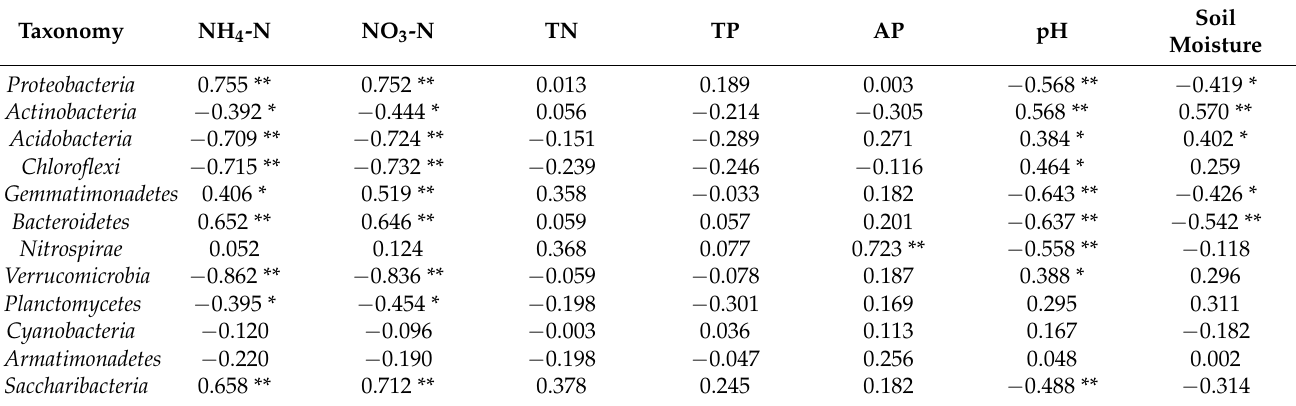
Table 4. Pearson’s correlations between the bacterial phylum and soil